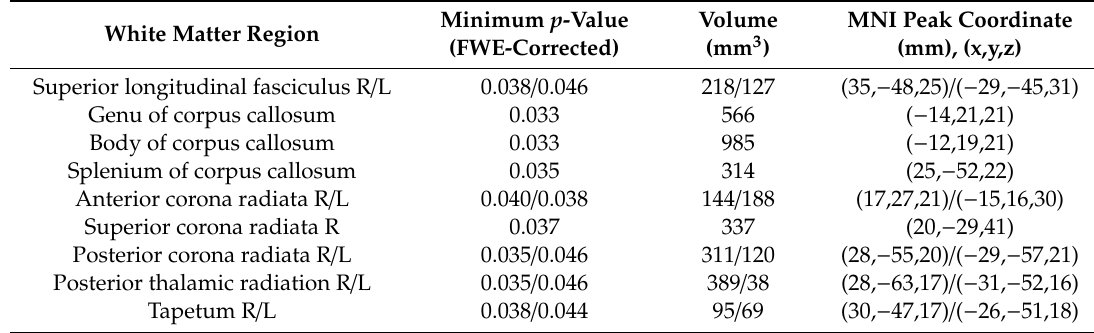
Table A15. White matter regions from the ICBM-DTI-81 White Matter Atlas for which significant decreased RD values were found in CM compared to HC including the duration of the migraine, presence of aura and medication overuse headache as